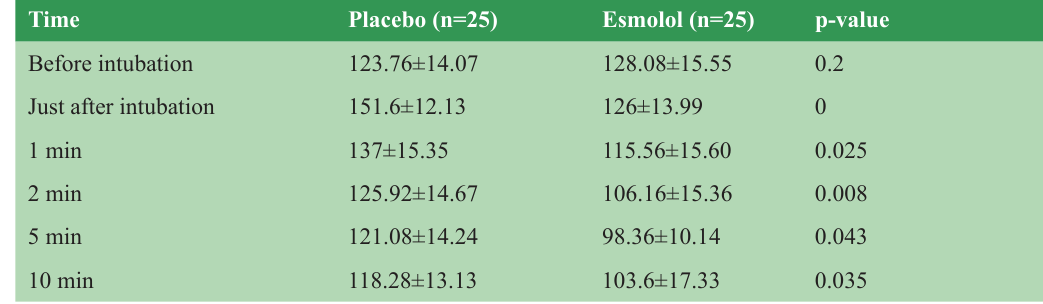
Table 3: Mean systolic blood pressure (mmHg) between placebo and lidocaine groups Time Placebo (n=25) Lidocaine (n=25) p-value Before intubation 123.76±14.0 Just after intubation